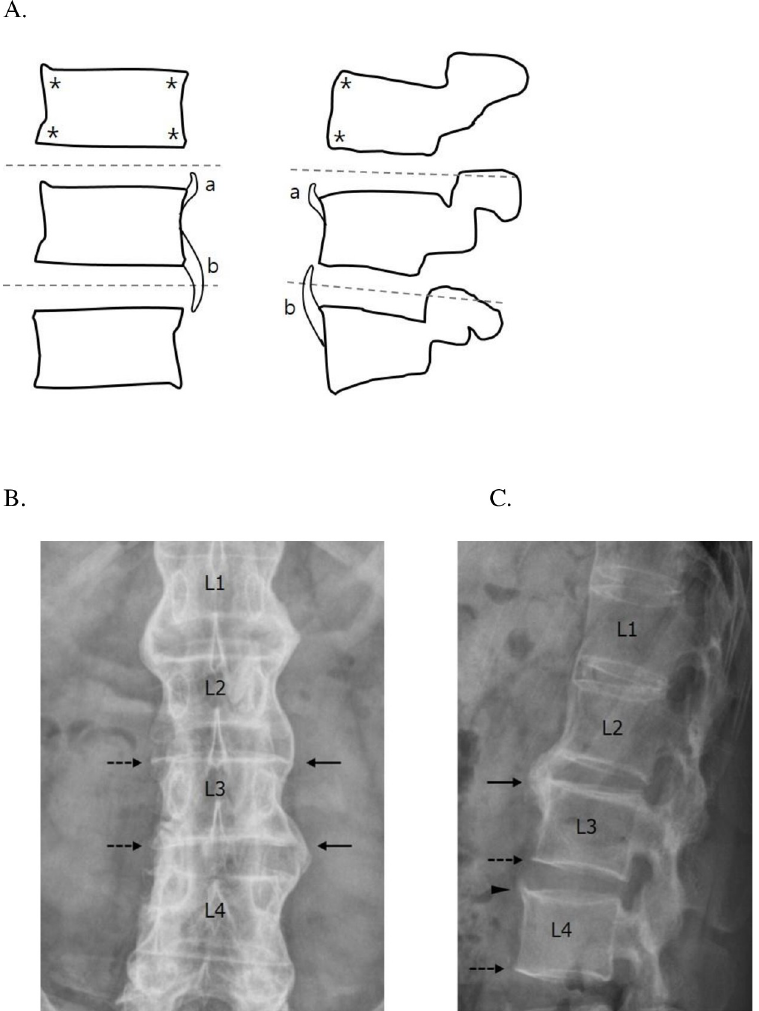
Fig 1. Schematic presentation for bone bridge scoring. (A) Schematic coronal and sagittal views of vertebrae with syndesmophytes. The gray, dotted line indicates the middle of the intervertebral disc space (IDS). Scoring was performed at the four corners of the coronal view and at the two corners of the anterior side of the sagittal view per vertebra (asterisk) with 0 or 1 point. A score of 0 is given for no syndesmophyte or < 90% syndesmophyte (a), and a score of 1 is given for � 90% syndesmophyte of the IDS (b). (B) Anteroposterior radiographic image of the lumbar spine. At L3, a bridging syndesmophyte or ankylosis is seen (black arrow). A score of 1 is given for the upper left corner of L3 and the lower left corner of L3. No syndesmophytes are present at the right corner of L3 (dashed arrow), which is given a score of 0. (C) Lateral radiographic image of the lumbar spine. At the anterior side of L4, a syndesmophyte is growing from the upper corner (arrowhead) but does not reach � 90% of the IDS, which is given a score of 0. At the anterior side of the vertebrae units L2–L3 (black arrow), a bridging syndesmophyte is seen (black arrow), and a score of 1 is given for the anterior upper corner of L3 and the anterior lower corner of L2. No syndesmophytes are present at the anterior lower corner of L3 (dashed arrow), which is given a score of 0.